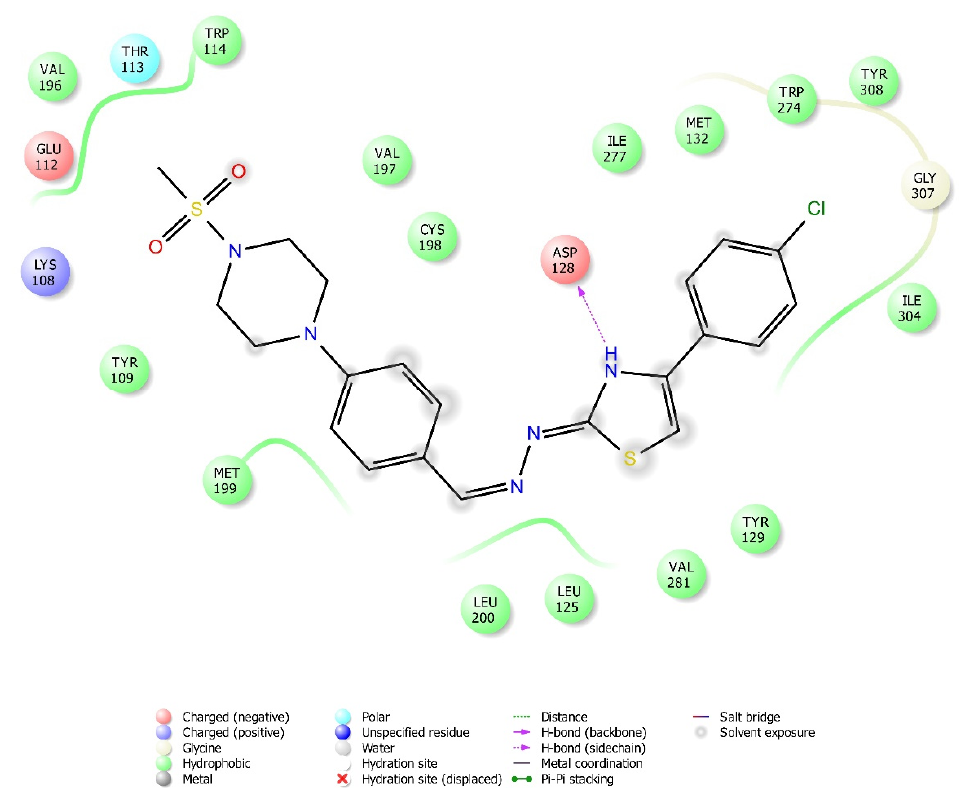
Figure 18. The two-dimensional interacting mode of compound 3g in the active region of δ -opioid receptor (PDB Code: 4N6H).